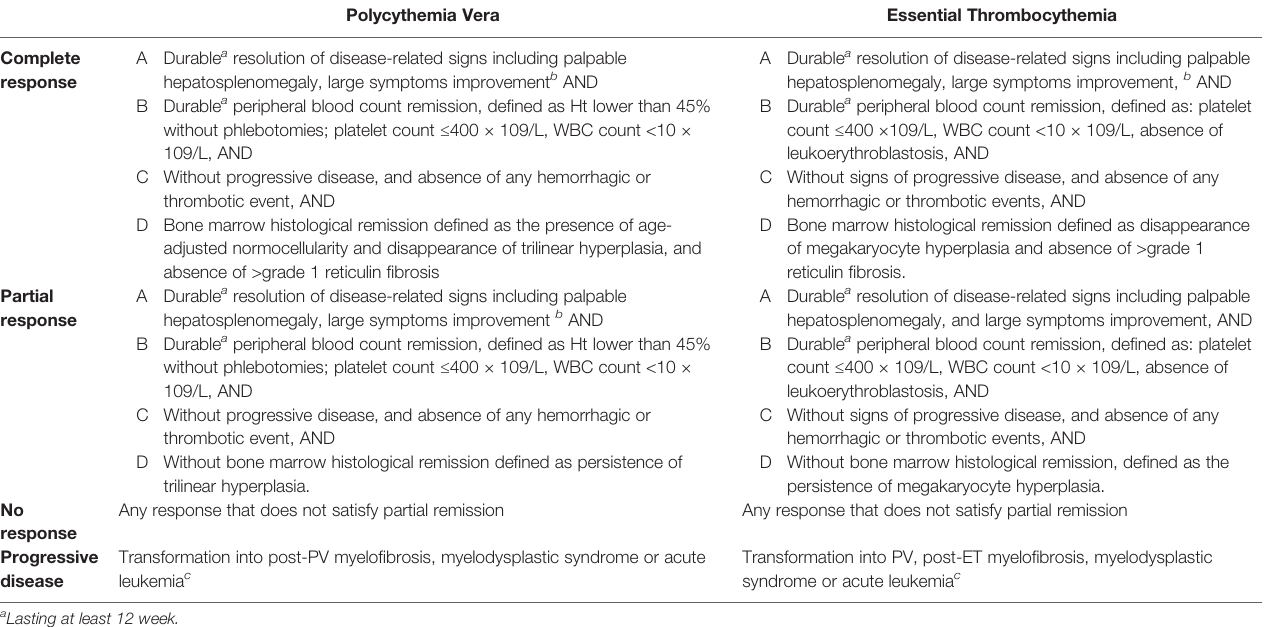
TABLE 1 | European LeukemiaNet (ELN) Response Criteria for Polycythemia Vera and Essential Thrombocythemia